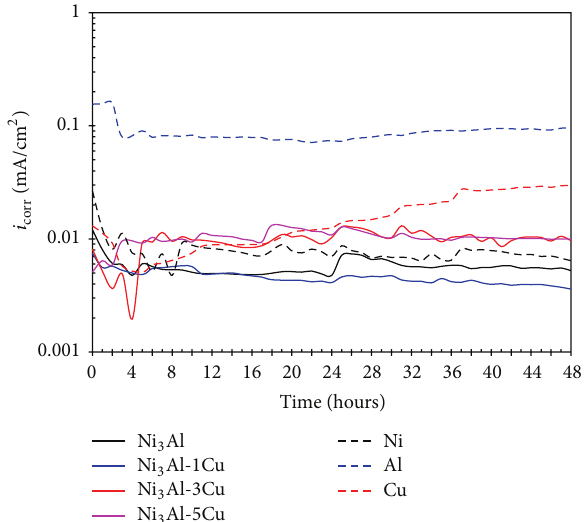
Figure 4: Variation of 𝑖 values for the tested materials in a 1.0M corr H 2 SO 4 solution as a function of exposure